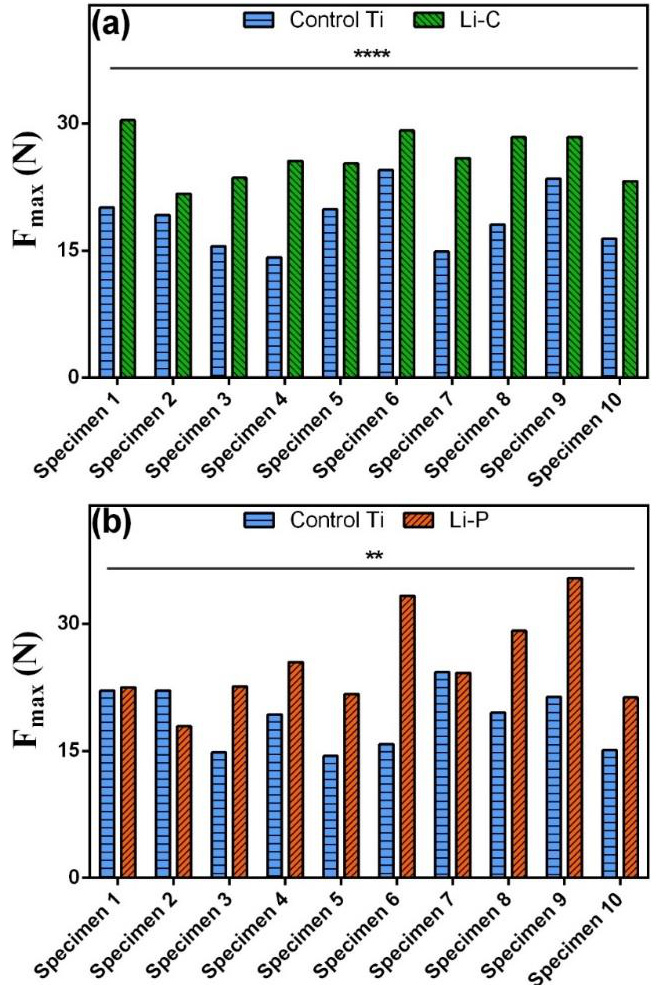
Figure 4. Detachment force, F max , of implants (n = 10) under tensile pull-out testing, inferred in the case of control 3D Ti implants (marked in blue color) and of those functionalized with ( a ) Li-C (marked in green color) and ( b ) Li-P (marked in orange color) coatings, at 4 weeks after surgery. **** Represents highly significant differences ( p ≤ 0.0001). ** Represents significant differences ( p ≤ 0.01).